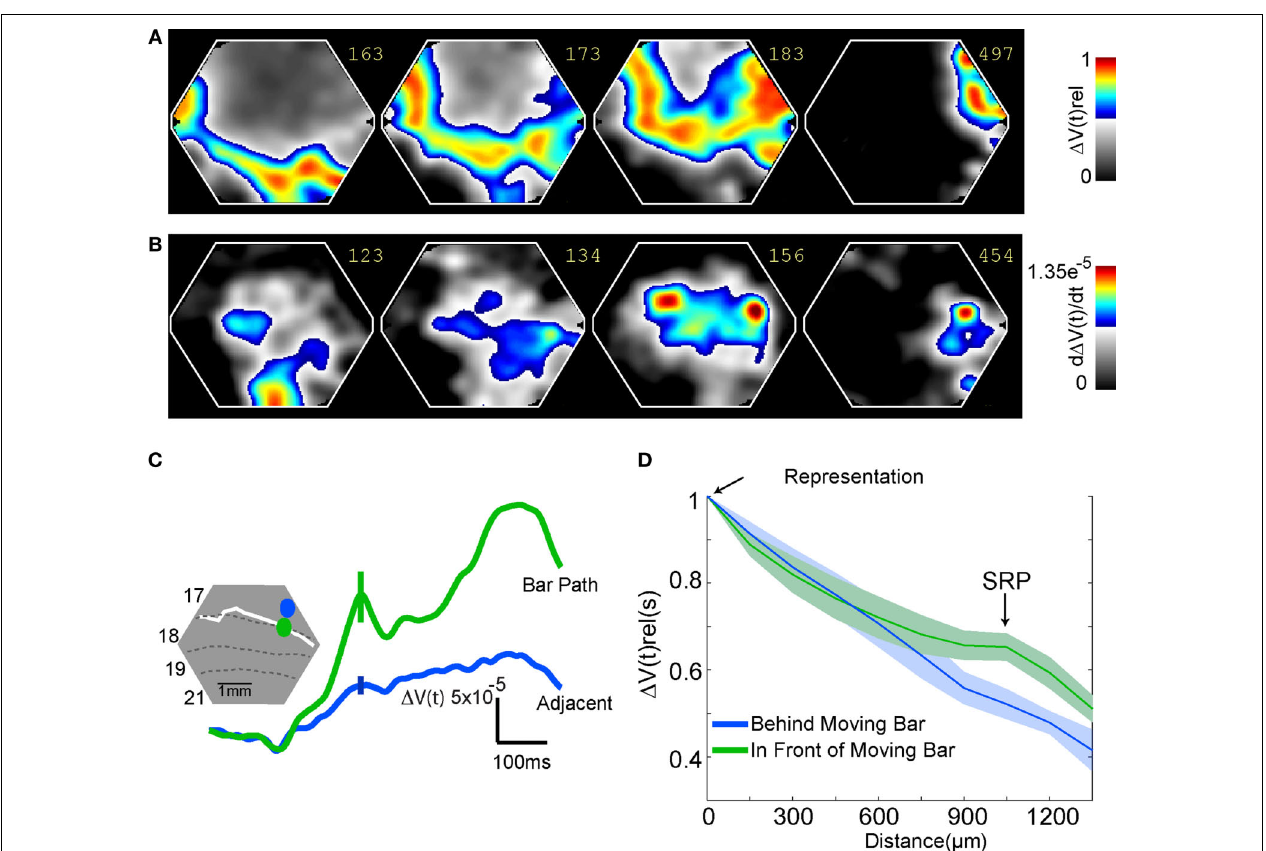
areas 17/18 within the motion path (individual example, green oval, inset). The solid blue line shows the mean Δ V ( t ) for all animals from areas directly adjacent to the motion path (individual example, blue oval, inset). Error bars indicate SEM at the time of the peak of the SRP. (D) The mean Δ V ( t )rel( s ) for all animals taken at the time of the SRP at 10 equidistant points behind, (blue line) and in front (green line) of the bar representation. The 10 points were part of the cortical motion path at or very close to the 17/18 cytoarchitectural border. To calculate the activity occurring behind the motion path (blue line), we used the two conditions in which the bar moved from CFOV. To calculate the activity in front of the motion path (green line), we the two conditions in which the bar moved from the peripheral FOV, The Δ V ( t )rel( s ) signal behind the moving object decays monotonically with distance. The Δ V ( t )rel( s ) signal in front of the moving bar shows an increase at 0.96–1.28 mm ahead of the object representation